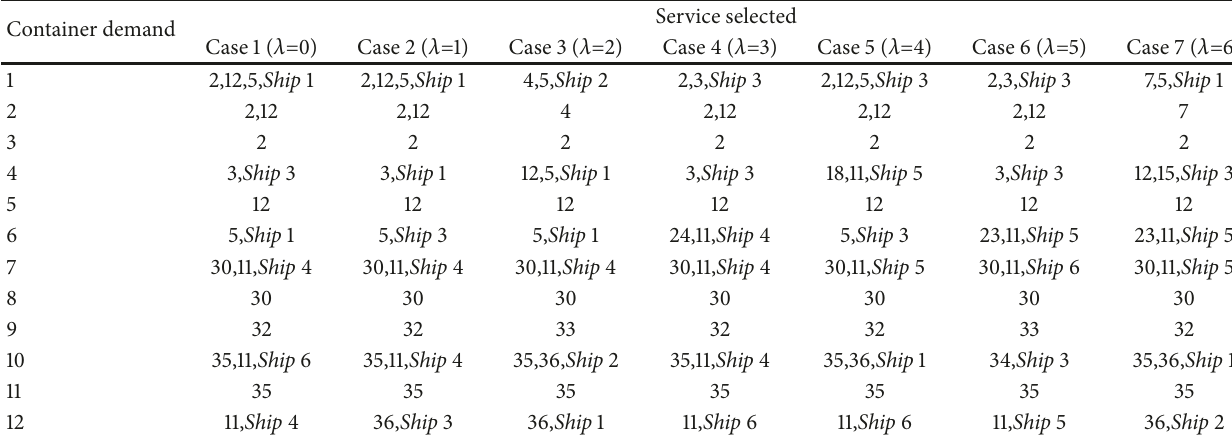
Table 8: The optimal service design under different multiplier 𝜆